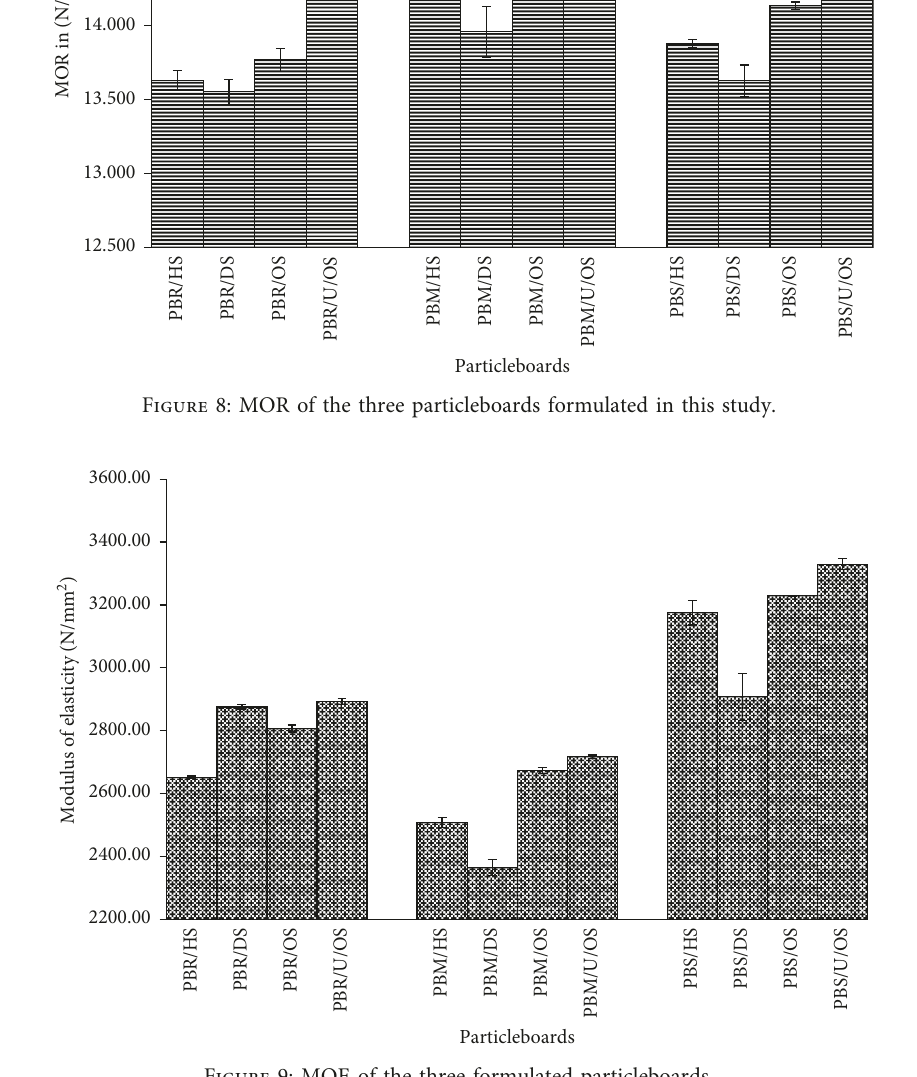
Figure 9: MOE of the three formulated particleboards.